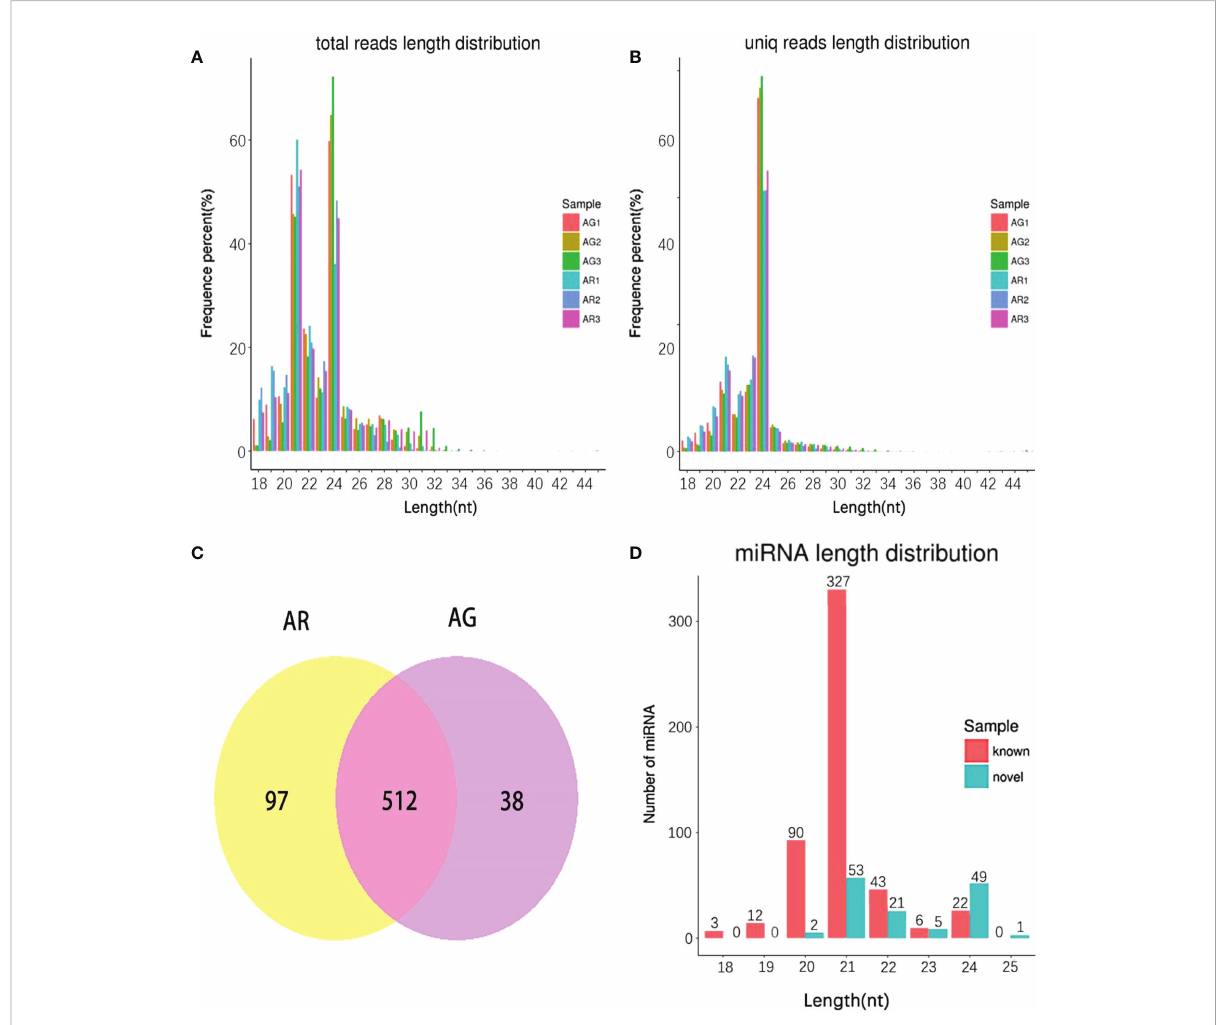
FIGURE 5 The length distribution of small RNA in A p. subsp. mono at different developmental stages and miRNA identity. (A) Length distribution of clean reads. (B) Length distribution of unique reads. (C) Venn Diagram. (D) Length distribution of known miRNA and novel